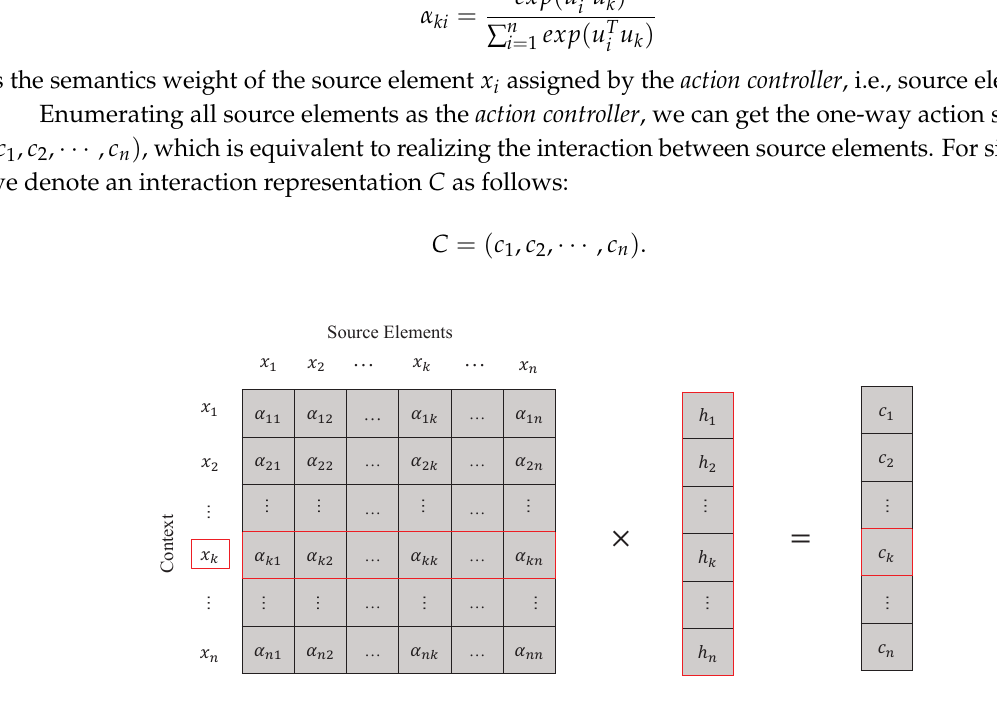
Figure 2. Process of Self-interaction Attention